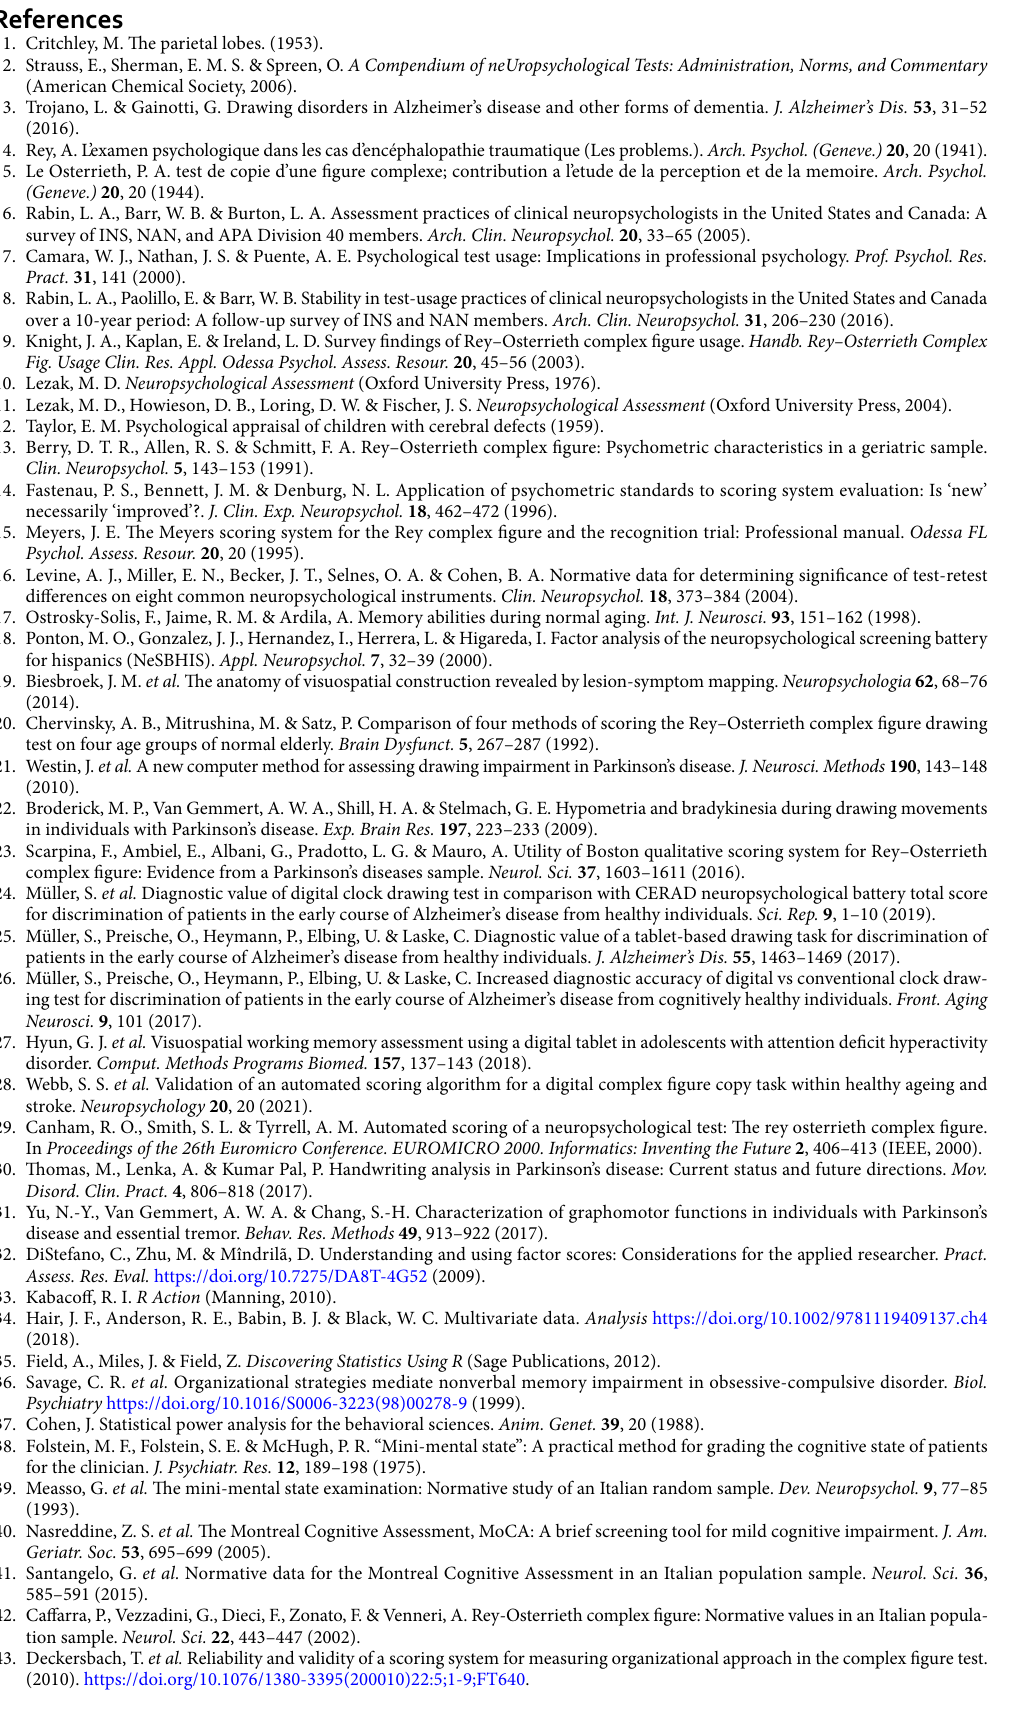
Fig. Usage Clin. Res. Appl. Odessa Psychol. Assess. Resour. 20 , 45–56 (2003). 10. Lezak, M. D. Neuropsychological Assessment (Oxford University Press,